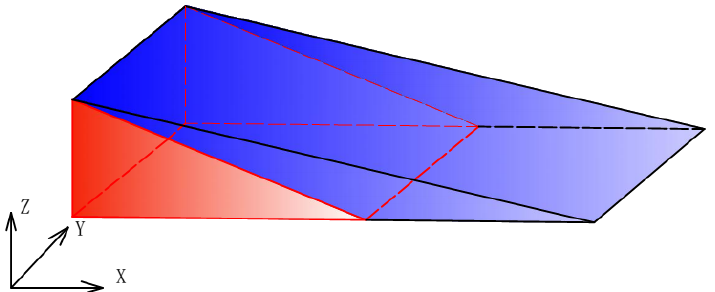
Figure 4. The principle of sediment volume calculation. The red area is the initial slope part and the blue area is the sediment volume.